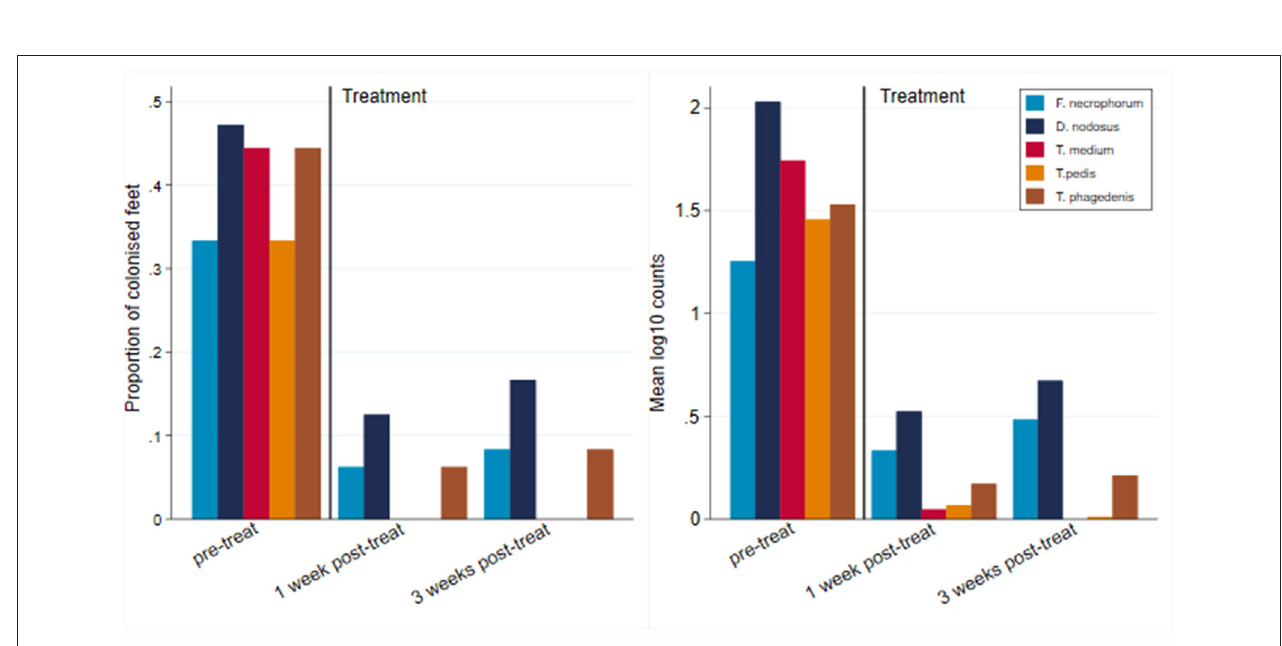
Frontiers in Veterinary Science |